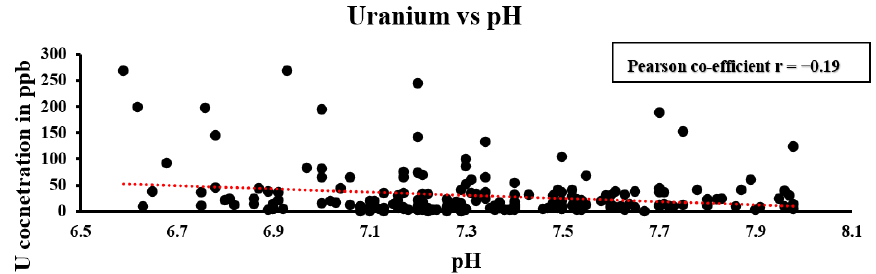
Figure 8. Pearson correlation between uranium concentration and pH.